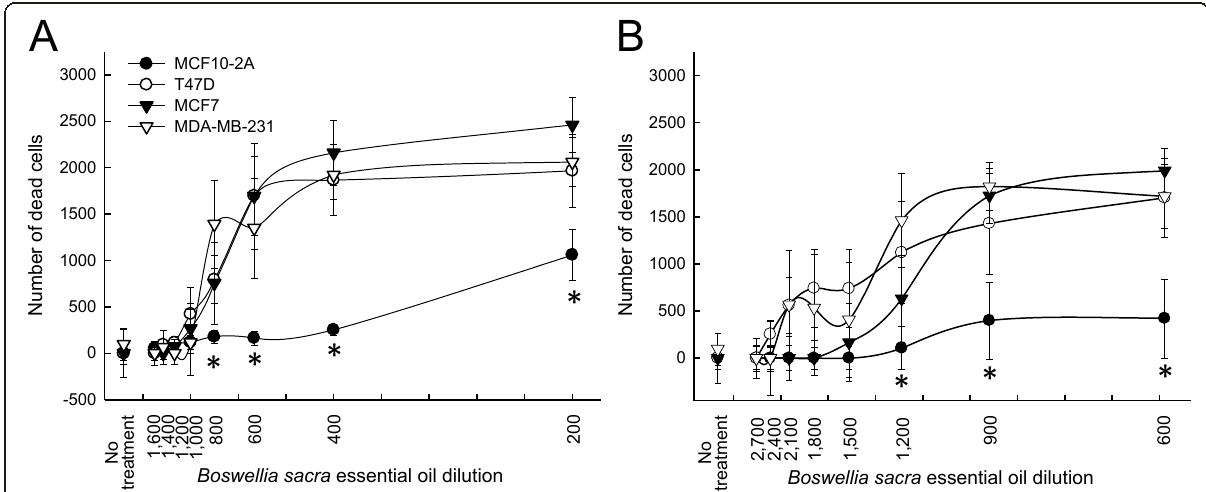
Figure 3 Quantitative analysis of Boswellia sacra essential oil-induced human breast cancer cell death . Human breast cell lines were seeded in each well of 96-well tissue culture plates at the concentration of 5x10 3 cells/well in triplicate. Following overnight adherence, cells were treated with either Boswellia sacra essential oil hydrodistilled at (A) 78 o C or (B) 100 o C. Cell death was determined at 3 hours following essential oil exposure by the LDH cytotoxicity detection kit. Data were presented as mean average numbers of dead cells ± SEM from at least 3 independent experiments. * indicates statistical differences of cell death between cancer cells and immortalized breast cells ( P <